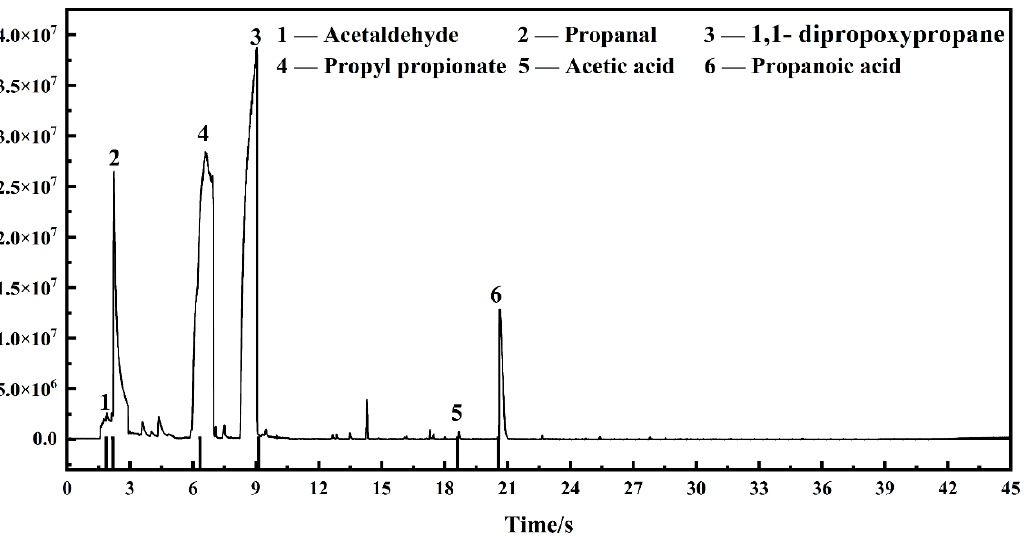
Figure 2. Total ion current (TIC) spectrum of I-ink.